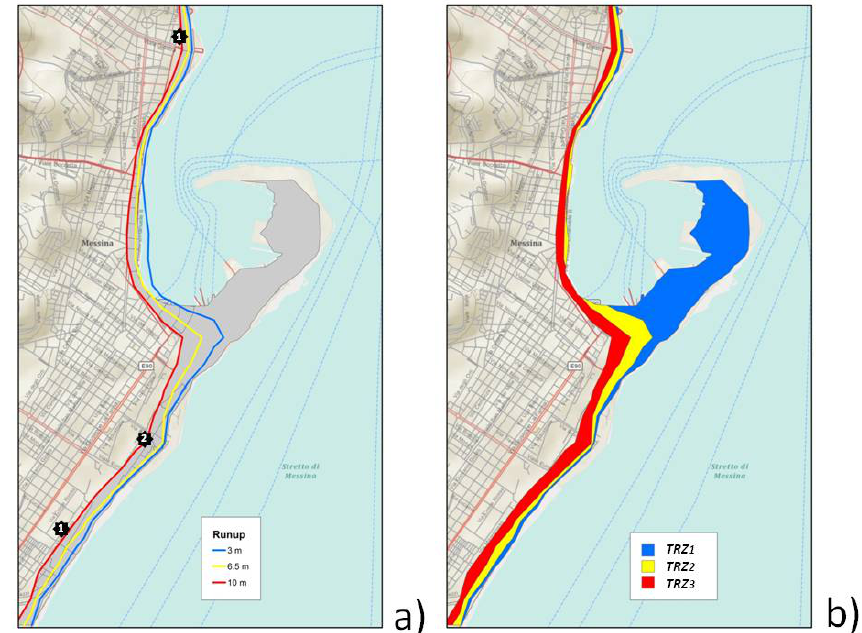
Fig. 1. Messina ISTAT sections on ArcGIS map: (a) the run-up isolines in Messina city (star symbols indicate the location of the correspond- ing number of buildings with 4 or more floors) and (b) the Tsunami Risk Zones TRZ i ( i = 1 , 2 , 3). The gray lines are the ISTAT section and the dark gray area in (a) (limited by 0.5m and 10m runup) is relative to the 54 sections of the